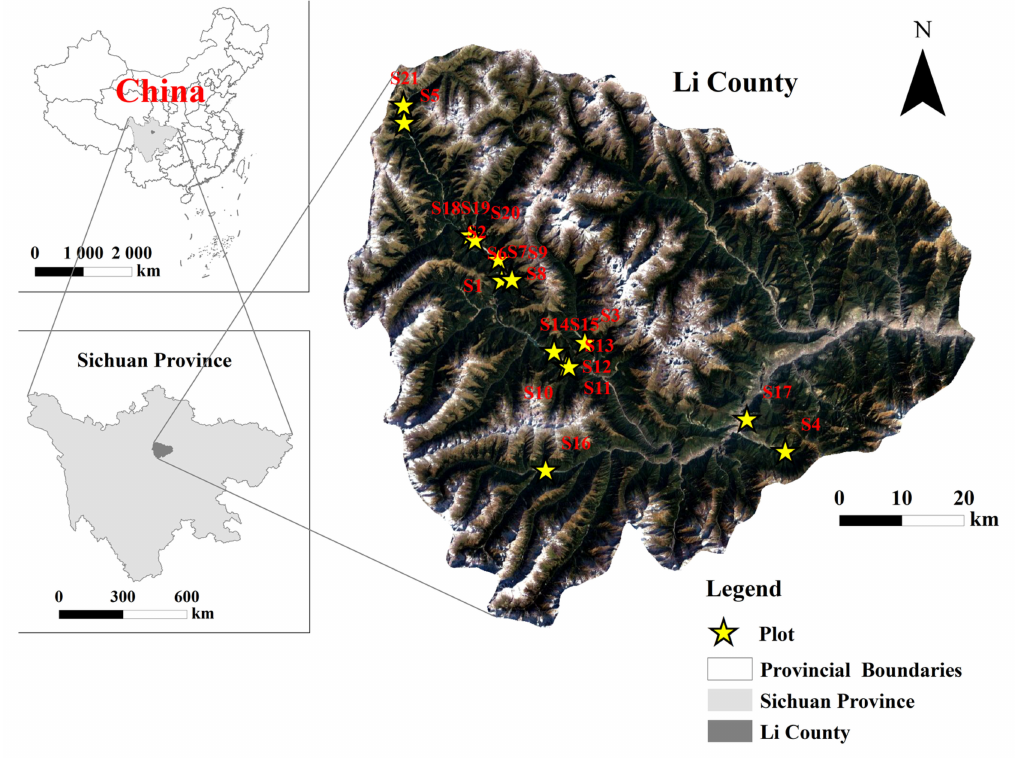
Figure 1. Location of study